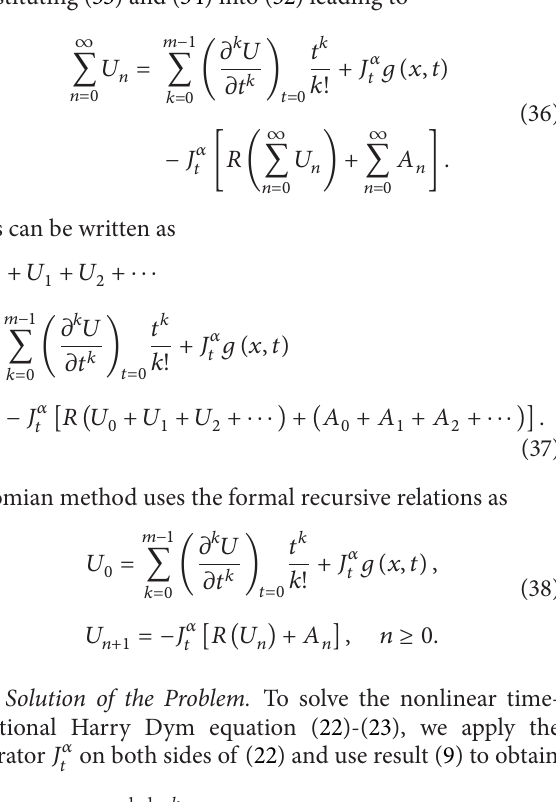
The components 𝑈 0 , 𝑈 1 , 𝑈 2 , . . . are determined recursively